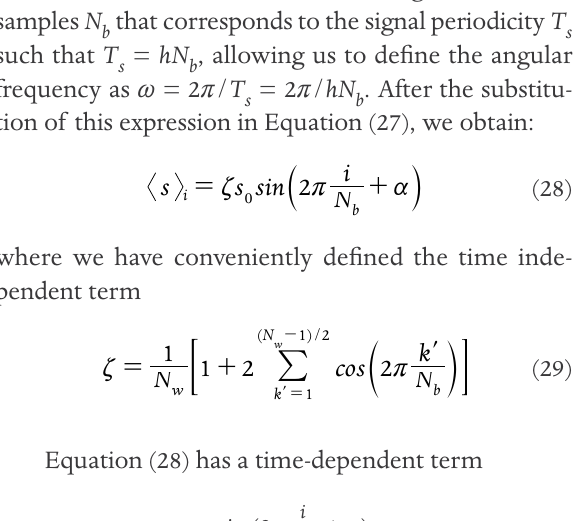
Figure 12. | g | as a function of N a sampled period of h = 1 (see text for details). The white dashed lines mark the corresponding minimum | g | values, associated with N = N , 2 N , 3 N w b b b